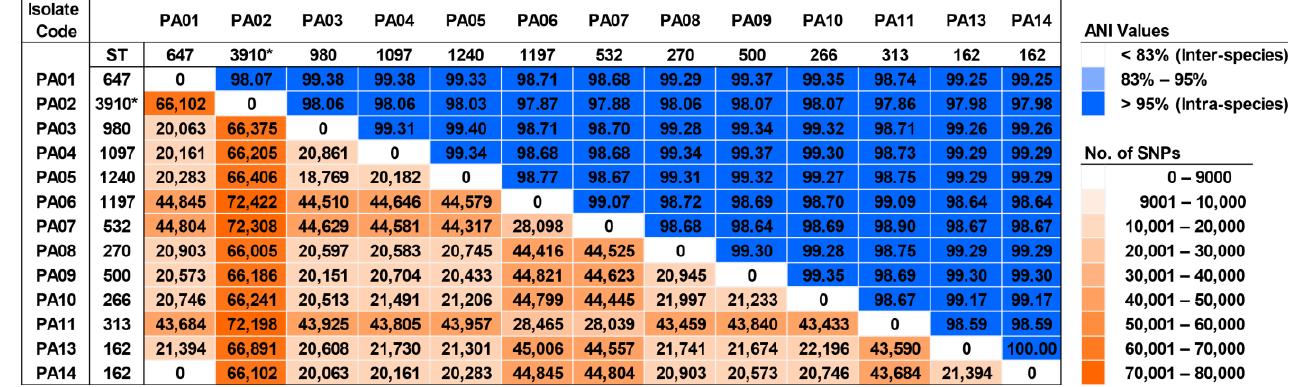
Figure 6. The matrix of pairwise average nucleotide identity (ANI) values and pairwise single nucleotide polymorphism (SNP) distance among the colonizing isolates of P. aeruginosa . ST, sequence type. * Novel ST.